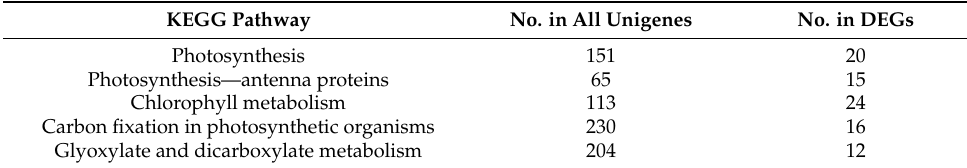
Table 2. Enrichment of key KEGG pathways among DEGs.